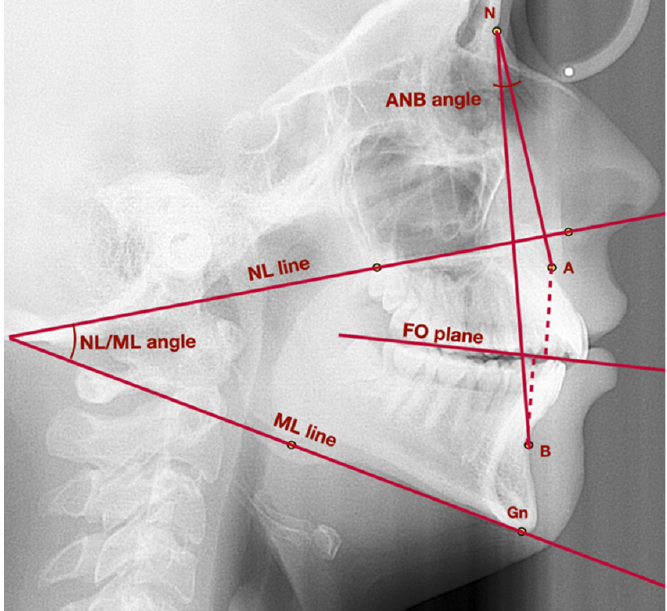
Figure 1. Lateral cephalogram with marked points, lines, and angles presented in Table 1 used to assess vertical and sagittal position of the mandible. A—point A; ANB—angle between lines NA and NB; B—point B; Gn—gnathion; FO plane—functional occlusal plane; ML—mandibular line; N—nasion; NL—nasal line; NL/ML—angle between lines: NL and